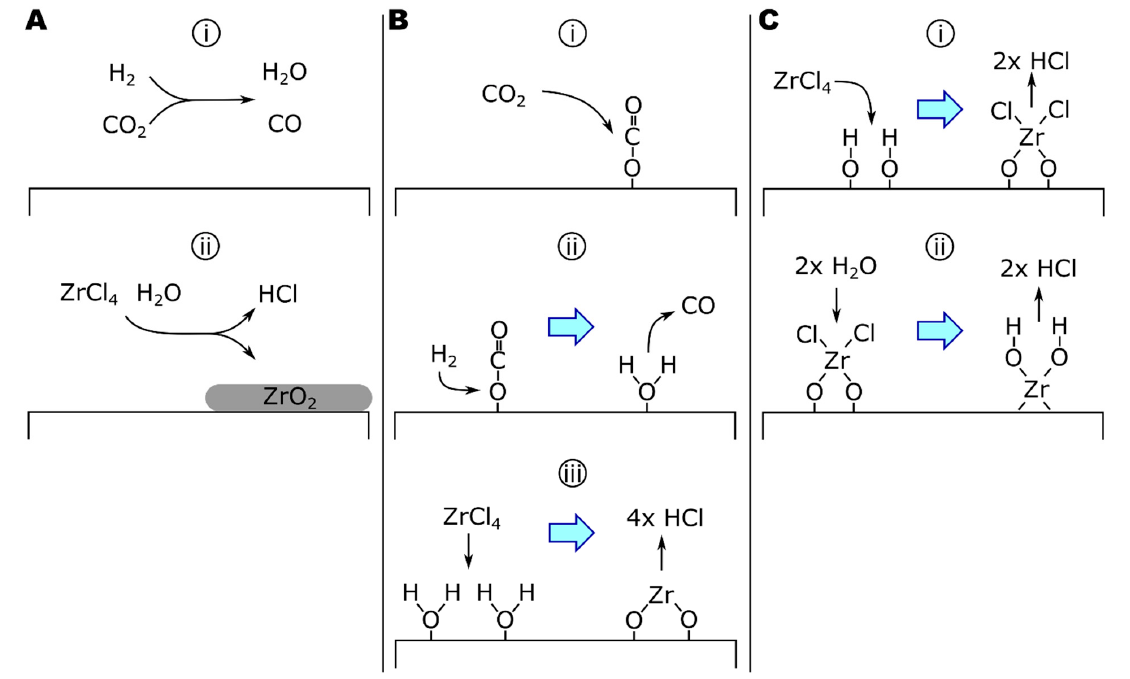
Figure 3. The growth of ZrO 2 by ZrCl 4 -CO 2 -H 2 via ( A ) homogeneous or ( B ) heterogeneous rWGS mechanics. ( C ) The growth of ZrO 2 by ZrCl 4 -H 2 O.